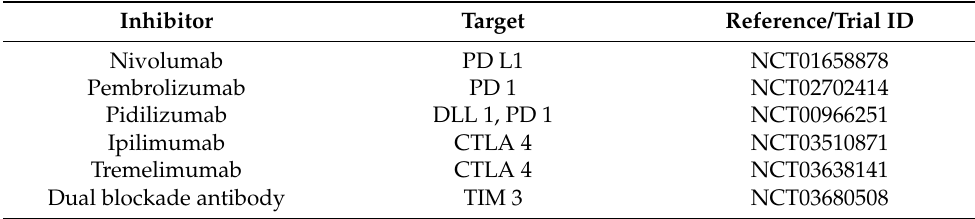
Figure 5. Mechanism of action of CTLA-4 immune checkpoint inhibitor. CTLA-4 can bind with the CD80/CD86 proteins, which are overexpressed in APC. This interaction blocks the cytotoxic effect of T cells by blocking the binding of T cells with the MHC protein present in cancer cells. Ipilimumab, an anti-CTLA-4 antibody, forestalls the interaction between CD80/CD86 and CTLA-4 and elicits an immune response. Table 6. Immune checkpoint inhibitors for HCC